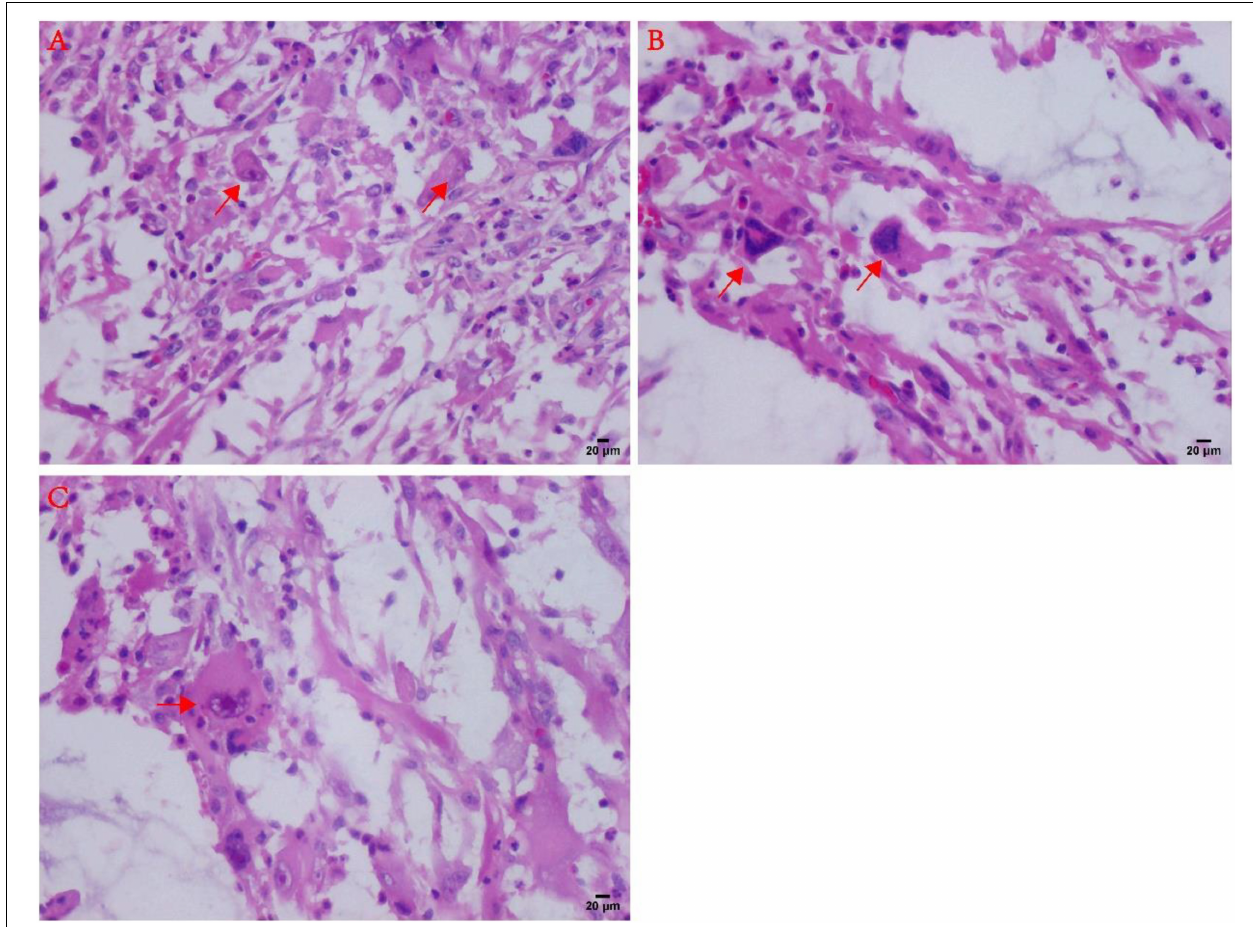
FIGURE 3 | Atypical microscopic features in MIFS. (A) Virus-like cells with abundant cytoplasm and nucleoli (arrows). (B) Large malformed cells with two enlarged nuclei shown by arrows; (C) R-S cell-like tumor cells with markedly large nucleoli